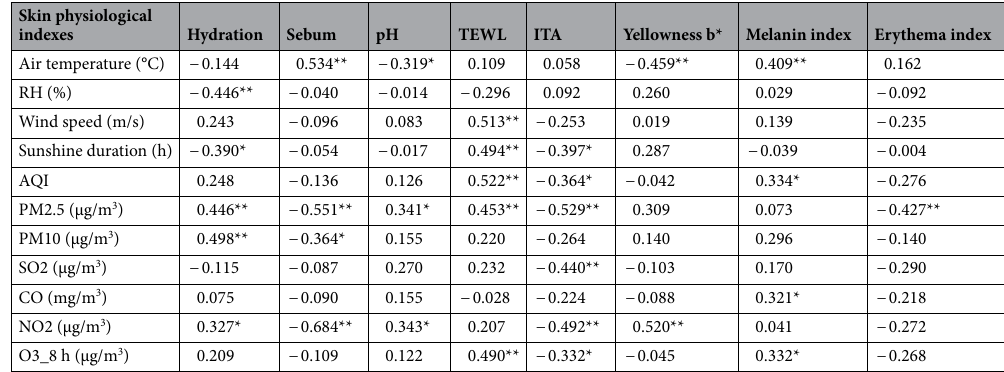
Skin physiological indexes Hydration Sebum pH TEWL Air temperature (°C) −